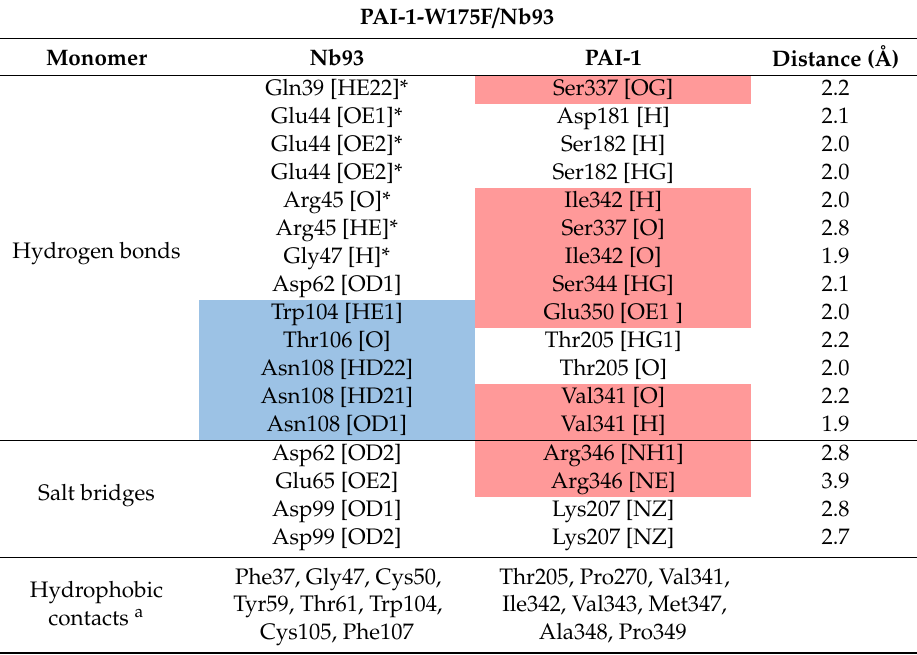
Table 2. Interactions between PAI-1 and Nb93 in the crystal